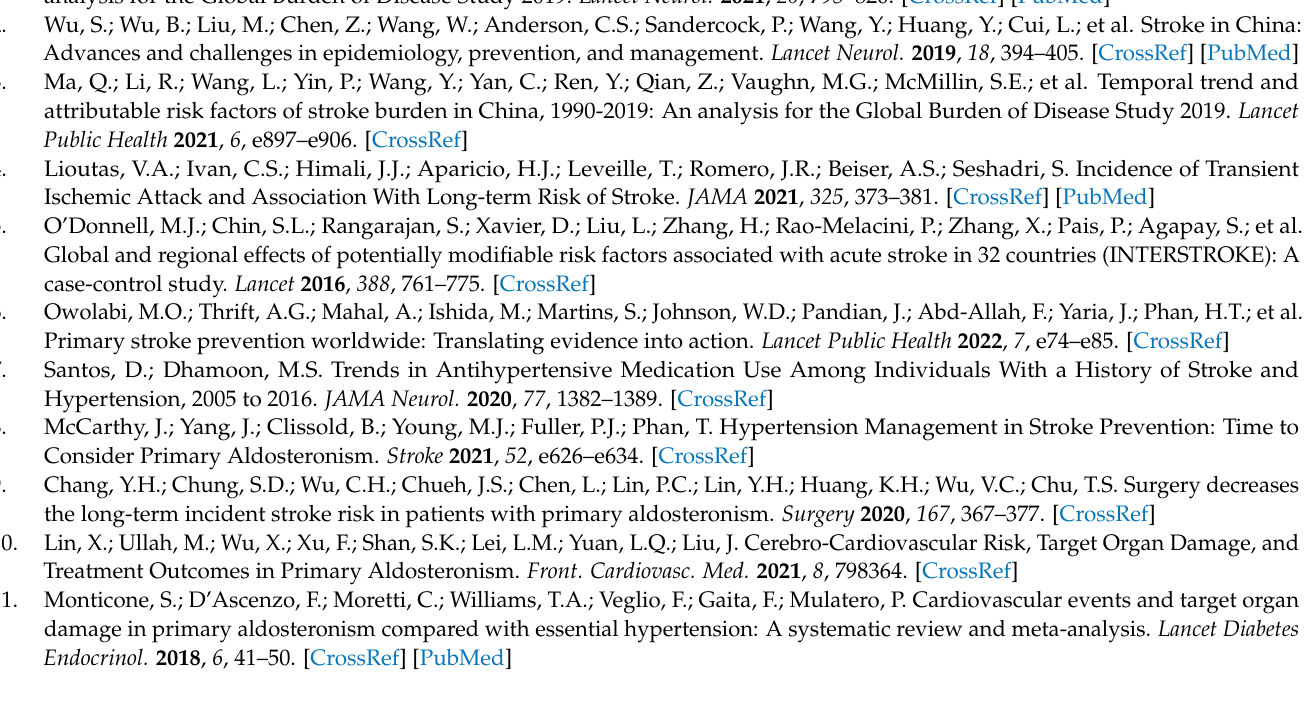
spironolactone and outcomes in other subgroups. (A) total stroke, (B) ischemic stroke, (C) hemor- rhagic stroke; Figure S3: forest plot showing results of sensitivity analyses based on different analysis strategies; Figure S4: STROBE participant flow diagram; Table S1: sensitivity analyses by excluding subjects with ages of more than 80 years in propensity-score-matched cohort; Table S2: sensitivity analysis excluding outcome events within the first year of follow-up in propensity-score-matched cohort; Table S3: competing risk models for the association of spironolactone use with the risk of stroke in propensity-score-matched cohort; Table S4: incidence of hyperkalemia events in patients in the spironolactone-use and non-use groups after propensity score matching; and Table S5: list of medications included in the